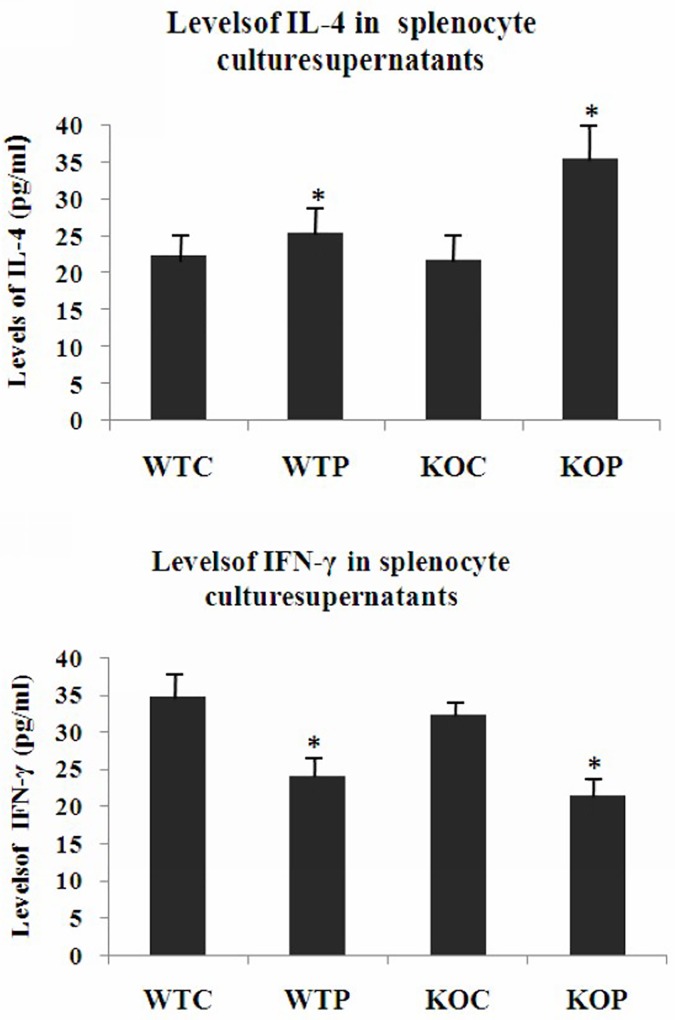
Levels of IL-4 and IFN-γ in Mouse Splenocyte Culture Supernatants.WTC: wild-type control group; KOC: CXCR3KO control group; WTP: wild-type HDMP test group; KOP: CXCR3KO HDMP test group. The levels of IL-4 were significantly increased in splenocyte culture supernatant derived from sensitized mice, and the levels of IFN-γ were decreased. Furthermore, the level of IL-4 was significantly different between the KOP and WTP groups; WTC: n = 4; WTP: n = 6; KOC: n = 6; KOP: n = 5; *P<0.01, HDMP vs. control; #P<0.01, CXCR3KO vs. wild-type.